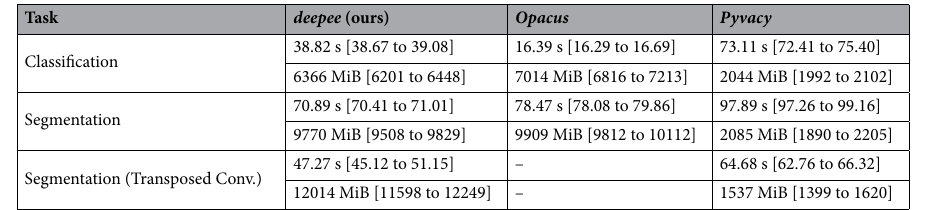
Table 3. Computational performance (median time for N = 25 batches of 32 examples in seconds over N = 5 repetitions) and mean peak memory consumption (one batch of 32 examples in MiB, N = 6 repetitions) of the compared frameworks for the classification and segmentation benchmarks. Ranges in angled brackets. The Segmentation (Transposed Conv.) row showcases framework performance in a U-Net architecture using transposed convolutions. Opacus is incompatible with this layer